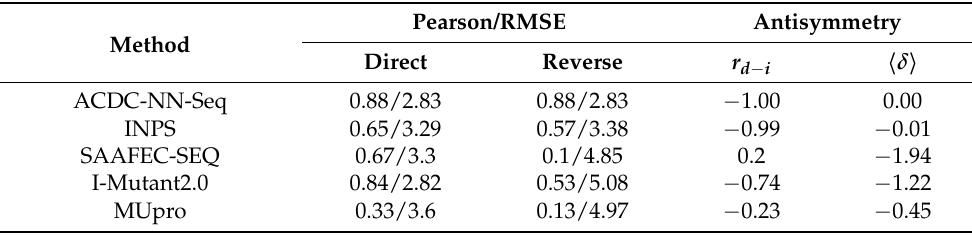
Table 7. Results on Frataxin Challenge in CAGI5 [30]. The INPS, SAAFEC-SEQ and I-mutant2.0 results were obtained using their stand alone code, those of MUpro were obtained using the web- server